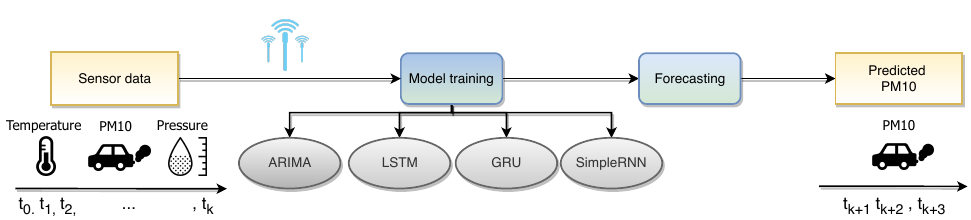
Figure 1. Data flow of the proposed method for air pollution